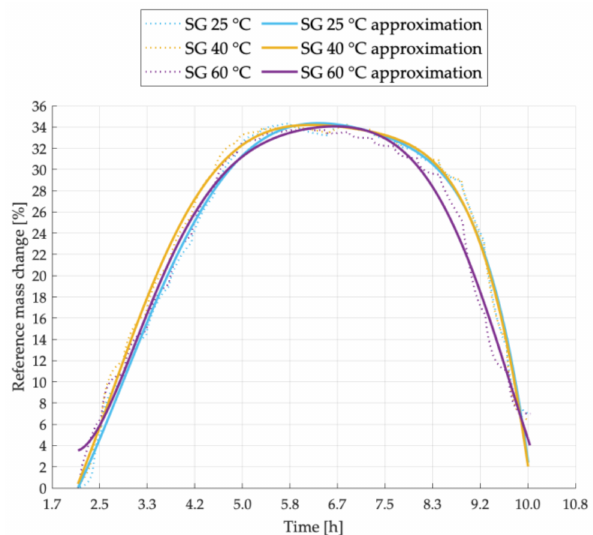
Figure 1. Sorption kinetics graph for SG sample tested at temperatures of 25 ◦ C, 40 ◦ C, 60 ◦ C.